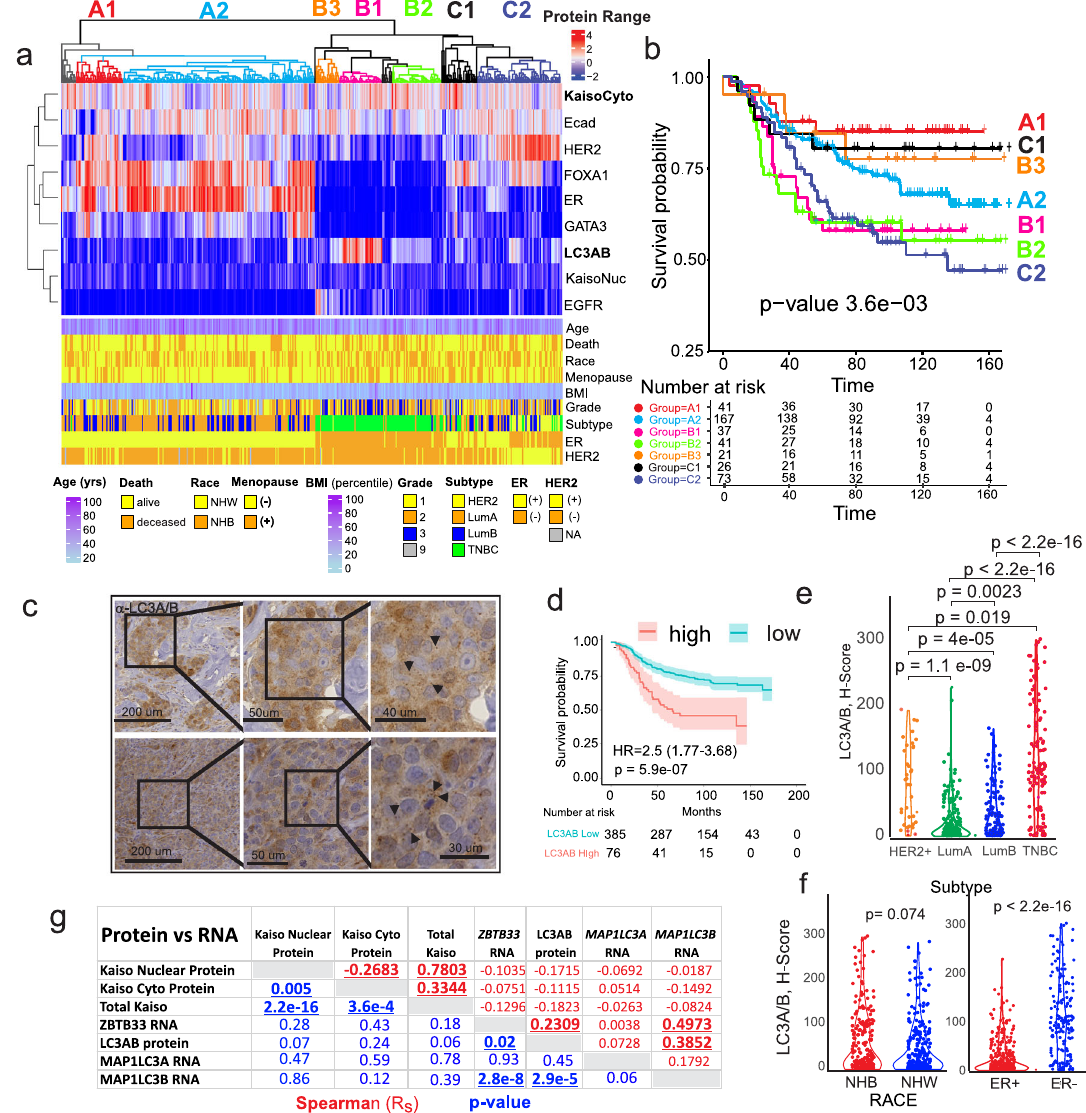
Fig. 3 Quantitative comparison of digitally scored functional and predictive biomarker abundance reveals associations between cytoplasmic Kaiso and the autophagy-related antigen, LC3A/B, that correlate with subtype and survival. a Unsupervised hierarchical clustering of the nuclear, membrane and cytoplasmic biomarker H -scores for each of ( N = 555) patients is shown in correlation with patient clinicopathologic and demographic attributes (below). b Kaplan – Meier survival analysis of speci fi c antigen expression clusters (identi fi ed by color code) in a demonstrating associations between cytoplasmic Kaiso, LC3A/B expression, and overall survival in TNBC. c Representative sample of LC3A/B immune-histochemical staining in breast cancer tissues. Arrowhead indicates subcellular puncta noted in the cytoplasm of multiple sections. d Kaplan – Meier survival analysis shows that high LC3A/B cytoplasmic staining is associated with poor overall breast cancer survival. e Like cytoplasmic Kaiso, LC3A/B staining is highly correlated with the more aggressive breast cancer subtypes LumB, HER2, and TNBC with the strongest association with TNBC. f LC3A/B shows a trend of higher expression in NHB versus NHW patients and is signi fi cantly more expressed in patients with ER- breast cancer. g Correlation between LC3A/B protein, nuclear Kaiso, cytoplasmic Kaiso, and the RNA levels for LC3A/B, ( MAPL1LC3A, MAPL1LC3B ), and Kaiso ( ZBTB33 ) showing the strongest correlation between LC3A/B and MAPL1L3 B RNA in addition to ZBTB3 3 RNA and MAPL1LC3B RNA. Spearman correlation is shown in red. p -value for Spearman correlation is shown in